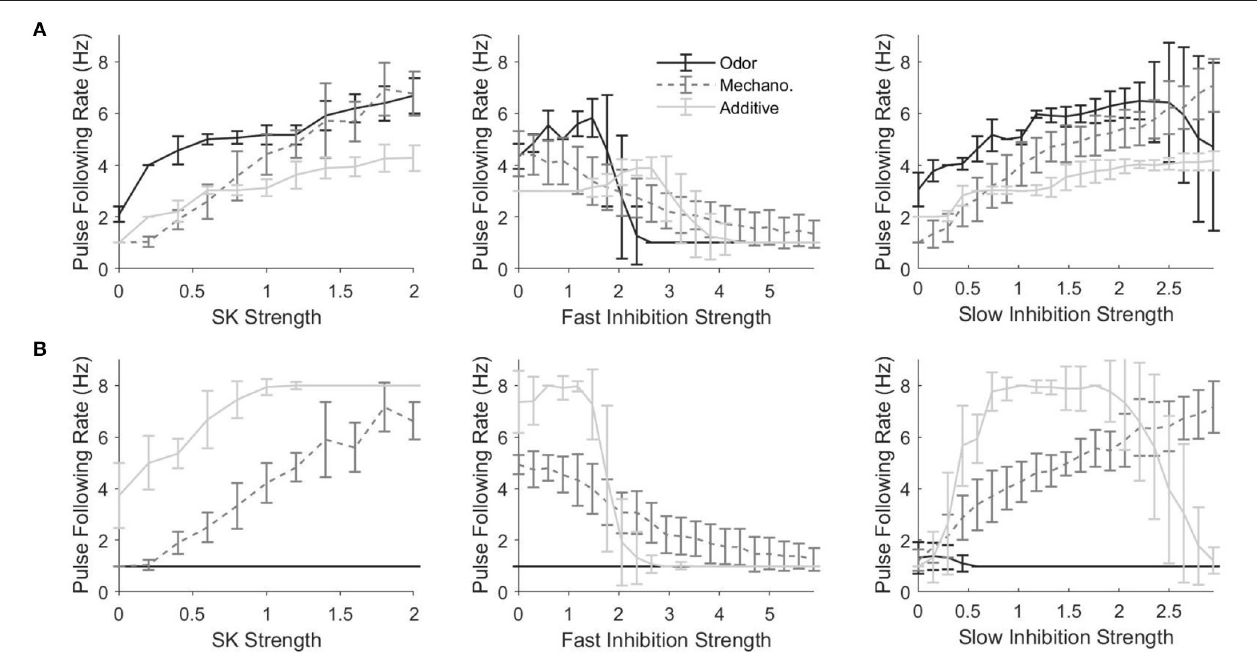
FIGURE 7 | Pulse Following Rate as a function of the strength of the SK current (left), fast inhibitory synapses (center), and slow inhibitory synapses (right) for a single odor-receiving (A) and a single non odor-receiving (B) PN within the network. Data are shown for the odor only, mechanosensory only, and additive sensory integration stimulus scenarios. The pulse following rate is a measure akin to a cutoff frequency—i.e., the highest pulse frequency at which the PN response can track the temporal structure of stimuli delivered in the form of a train of pulses (see section 4 for details). Values on the x-axis are normalized by the standard values of the SK current, fast inhibitory synapses, or slow inhibitory synapses within the network, with a value of 1 indicating standard strengths. In the standard network, SK current strengths vary from PN to PN, and are drawn from a Gaussian distribution; in the simulations in this figure, SK current strengths are fixed across PNs, and the standard value of the SK current strength is taken as the mean of Gaussian employed in the standard network. Data are averaged over 50